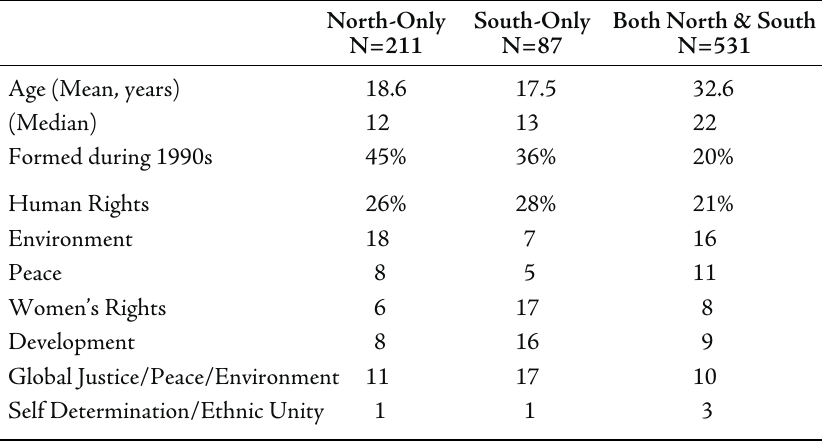
Table 5: Issue Focus of Sub-Regional vs. Trans-Regional